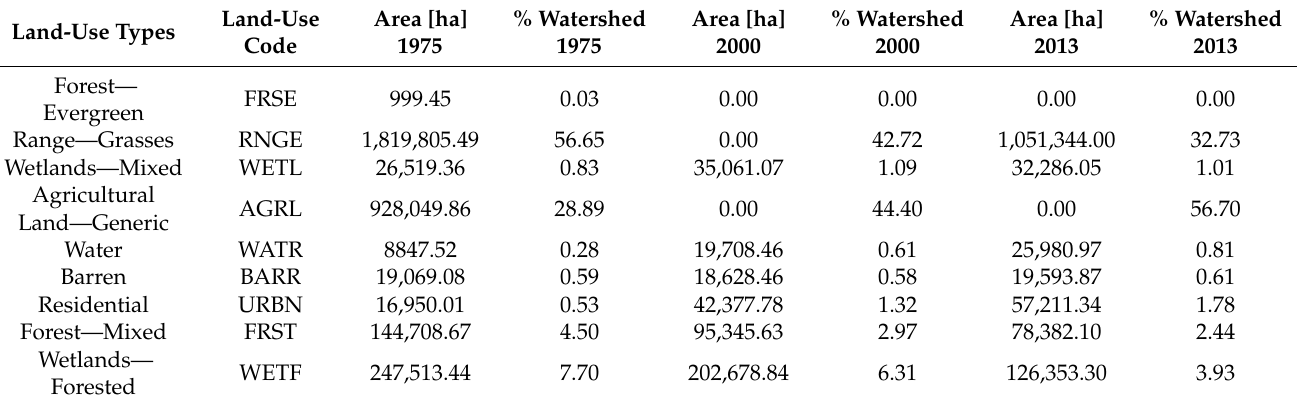
Table 4. Changes in land-use caused by anthropogenic activities between 1975–2013.